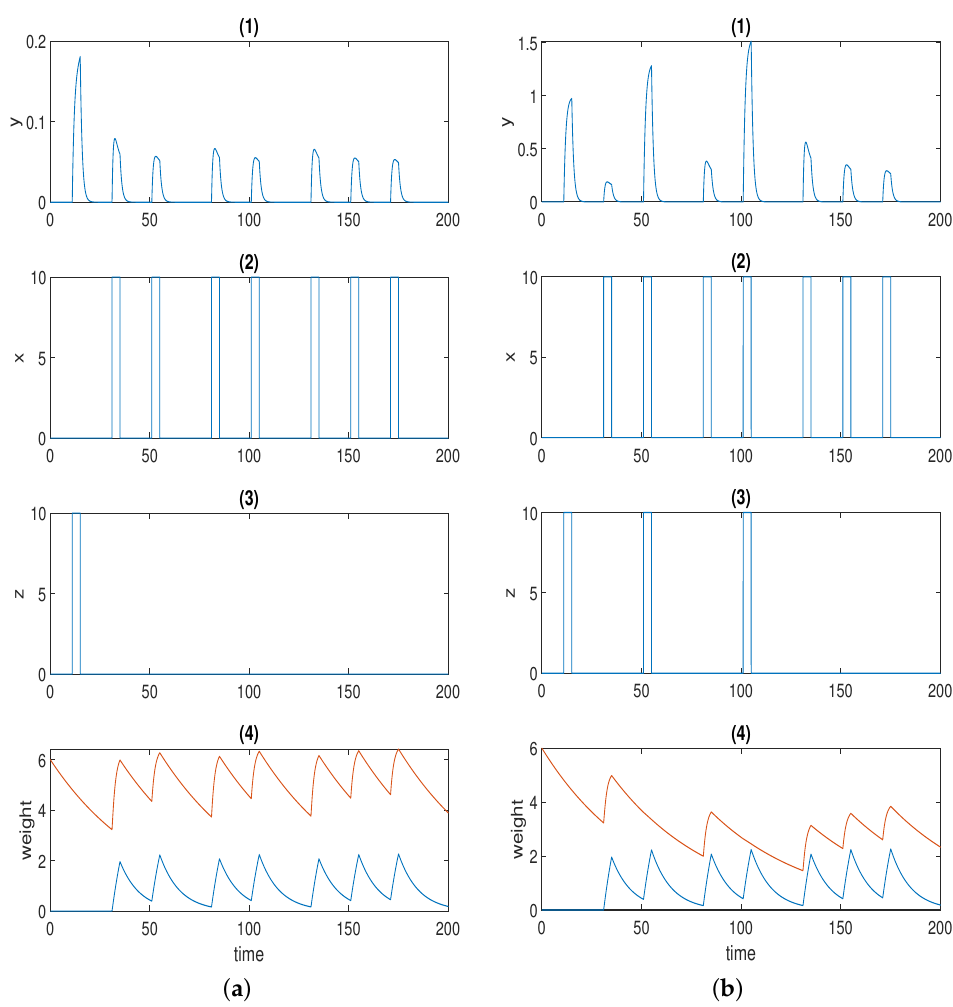
Figure 6. ( a ): Time series for the model with forced dissociation without conditioning (1) response molecule y ; (2), (3) conditioned stimulus x and unconditioned stimulus z ; (4) weight molecule u (blue) and v (red); a = 2, α yx = 2, α yz = 4, α xyz = 4, α ux = 0.6, α vx = 1.5, β u = 0.1, β v = 0.02. ( b ) Time series for the adjusted model with forced dissociation (1) response molecule y ; (2), (3) conditioned stimulus x and unconditioned stimulus z ; (4) weight molecule u (blue) and v (red); a = 2, α yx = 4, α yz = 1, α ux = 0.6, α vx = 1, β u = 0.1, β v = 0.02. Table 4. Parameter values used in the simulation for the adjusted model with forced dissociation (Equation (5)).